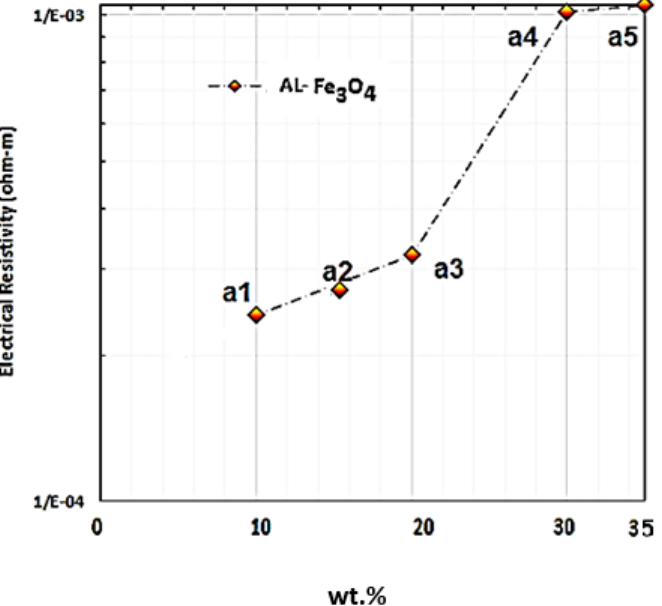
Figure 16. Electric resistivity of Al-Fe 3 O 4 composites for different weight percentages of Fe 3 O 4 at room temperature.